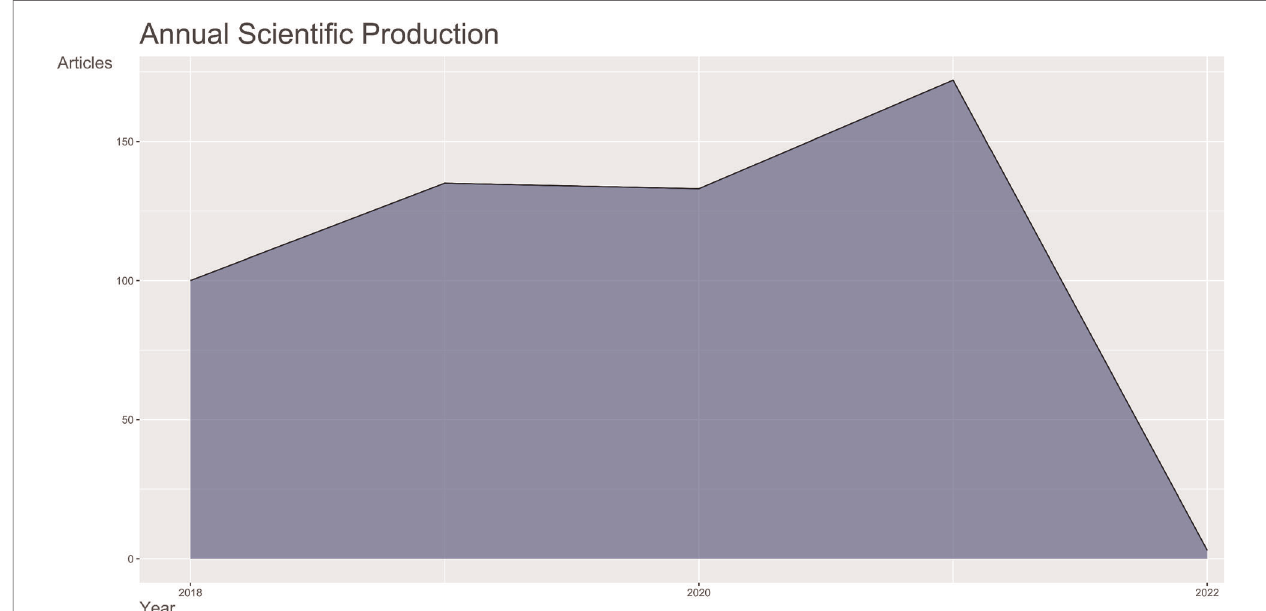
FIGURE 1 | Annul number of publications in the fi eld of stem cell precision medicine (2018 –